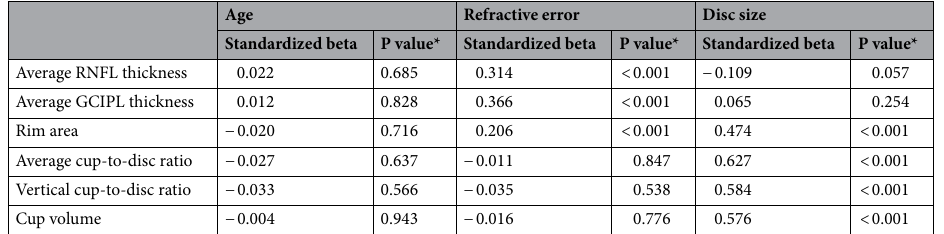
Table 3. Effect of age, interocular difference (right eye–left eye) in refractive error and disc size on interocular differences in optical coherence tomography parameters. RNFL retinal nerve fiber layer, GCIPL ganglion cell- inner plexiform layer. *Linear regression